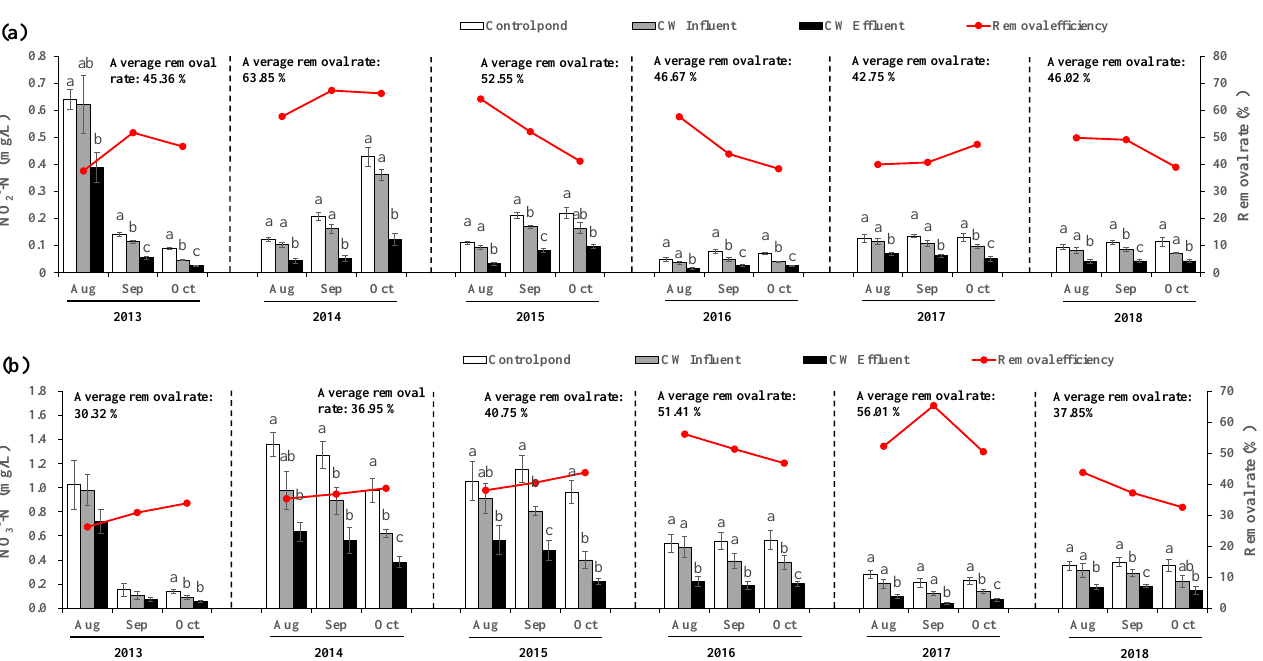
Figure 4. Concentrations of NO 2 − -N ( a ) and NO 3 − -N ( b ) in water samples collected from the control pond and the inlet and outlet of CW, and the removal efficiency during the monitoring period. The value is expressed as mean ± SE ( n = 6), and different small letters in bar graphs indicate significant differences ( p < 0.05) among the control pond, CW influent and CW effluent.